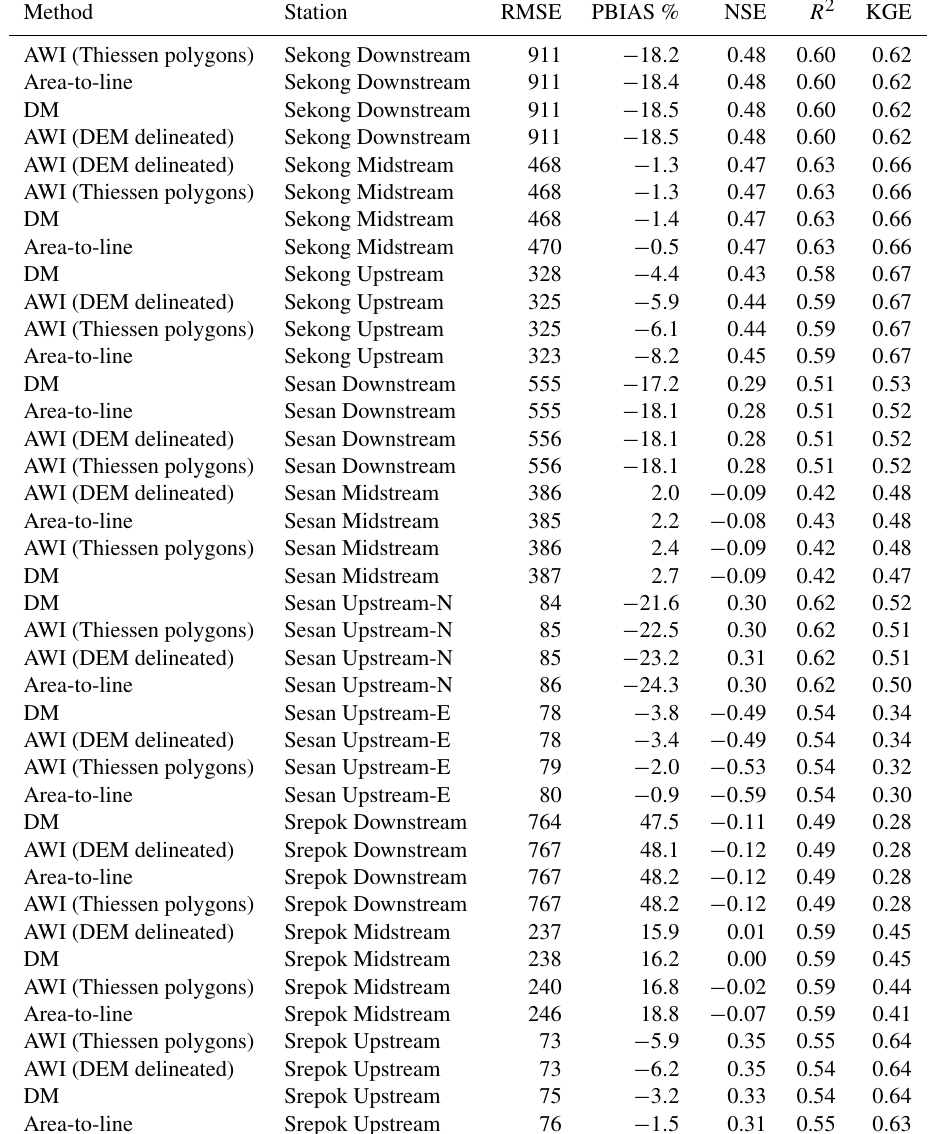
Table A1. The mean goodness-of-fit measurements of the tested downscaling methods at each monitoring station, averaged across all GHM– climate forcing pairs. Ordered by